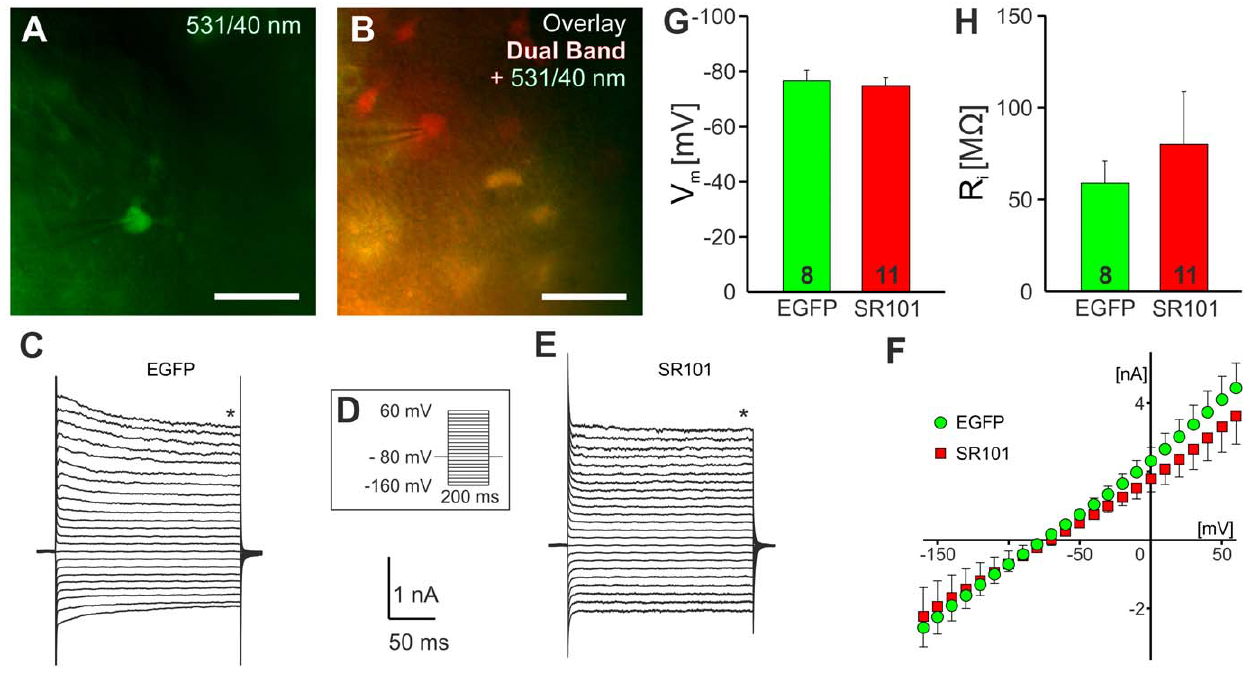
Figure 2. Electrophysiological characterization of SR101-positive cells in the hippocampus. A: CCD-camera image of an EGFP-expressing astrocyte using a EGFP-filter, 531/40 nm BP filter. The image was taken after the cell was approached with patch-pipette. B: Image of a whole-cell recorded SR101-loaded stratum radiatum cell that did not express EGFP. The picture was merged from the EGFP-filter image (531/40 nm, green) and the dual band filter image (EGFP/mCherry; F56-019, red). C: Membrane current traces of the astrocytes in (A) in response to the voltage-step protocol shown in D . E: membrane current traces of the SR101-positive EGFP-negative cell in (B). Capacitance artifacts have been truncated. F: Averaged I–V curves from EGFP-positive (EGFP; green) and SR101-positive EGFP-negative (SR101; red) cells. G,H: Statistical comparison of resting membrane potential (G) and membrane resistance (H).